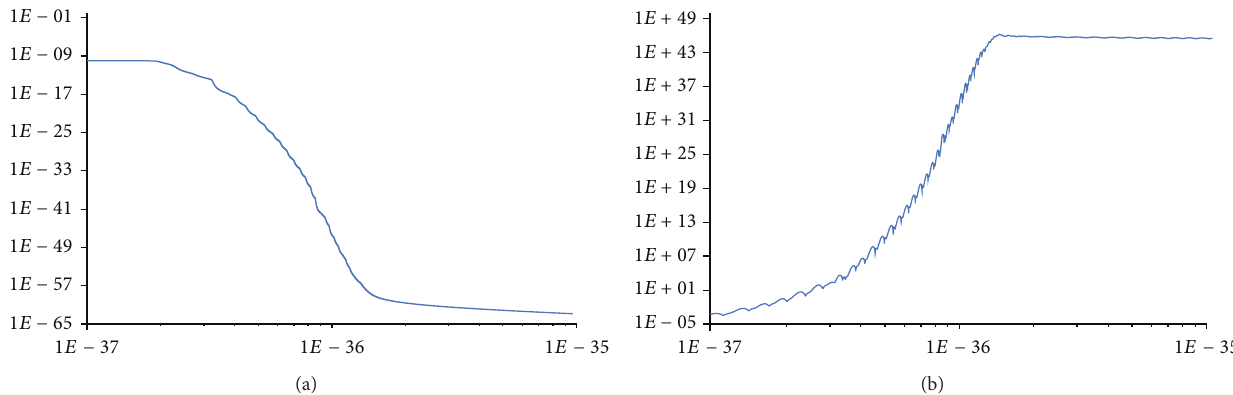
Figure 3: The (a) charge density and (b) magnitude of the gauge field throughout inflation (log-log scales).